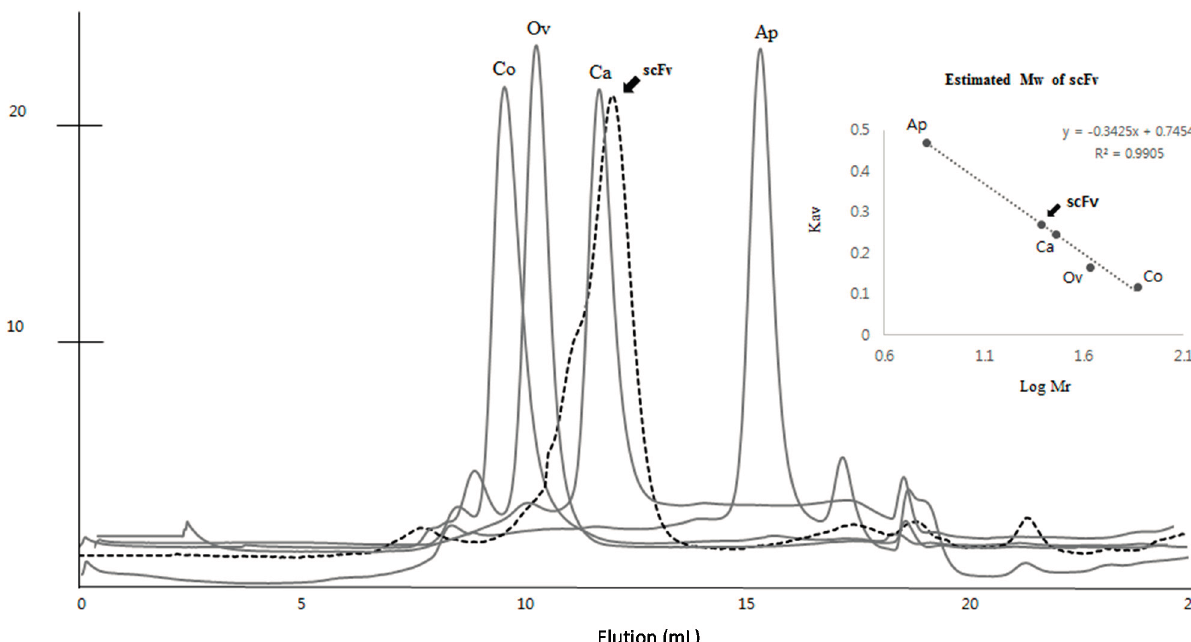
Figure 4. Molecular mass of scFv using a gel filtration column. Molecular weights for standard proteins are as follows: Conalbumin, 75 kDa, 9.55 mL; ovalbumin, 43 kDa, 10.31 mL; Carbonic anhydrase, 29 kDa, 11.65 mL; Aprotinin, 6.5 kDa, 15.33 mL; (gel filtration calibration kit LMW and HMW, GE Healthcare, Piscataway, NJ, USA) The scFv fragment, indicated by a black arrow, with the expected molecular weight of 29 kDa was eluted at the elution volume of 12.04 mL close to the carbonic anhydrase. The gel-phase distribution coefficient ( K av ) was calculated from: K av = ( V e − V o )/( V c − V o ) where V e is elution volume, V o (7.61 mL) is void volume (determined using blue dextran), and V c (24 mL) is column